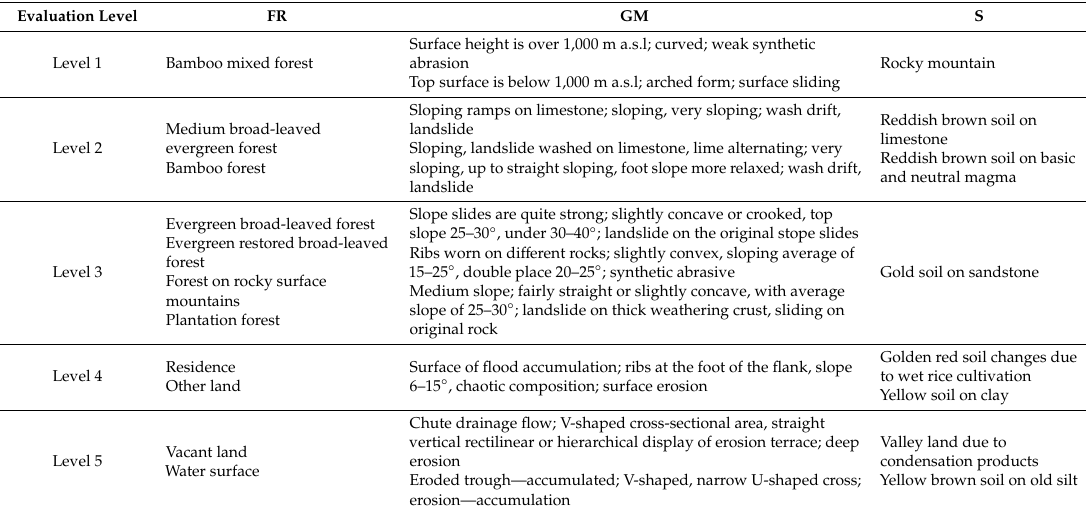
Table 2. Flash flood risk evaluation for geomorphology (GM), soil (S) and forest (FR) information layers. Evaluation